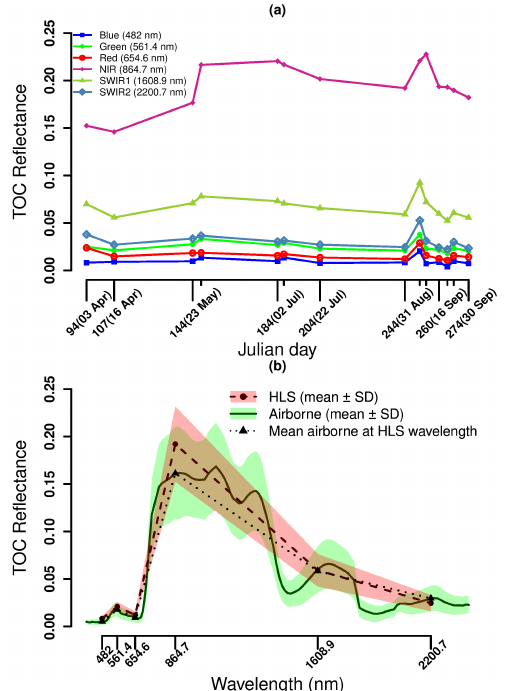
Figure 2. ( a ) Temporal variation in mean top-of-canopy (TOC) reflectance in each band extracted from harmonized Landsat-8 and Sentinel-2 (HLS) data within the target area defined by flux footprint (delineated in Figure 1); ( b ) mean and standard deviation (SD) of TOC reflectance on 31 August 2016 extracted from HLS and airborne data within the target area. The dotted line with triangular symbols is the airborne reflectance resampled to the HLS wavelengths. NIR: near infrared, SWIR: shortwave